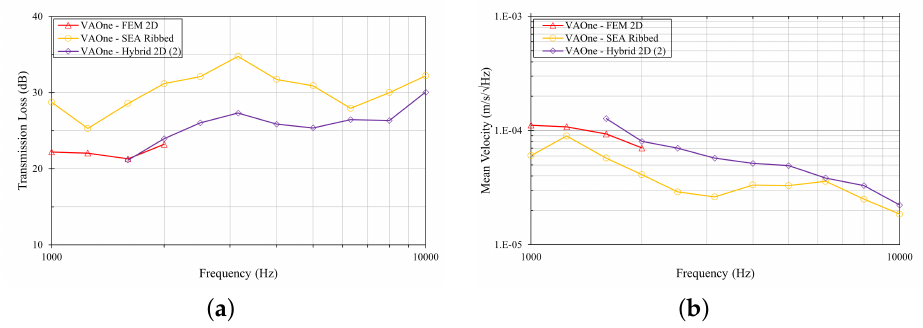
Figure 21. Vibro-acoustic responses of a panel with unconventional stringers: ( a ) sound transmission loss and ( b ) space-average mean vibration velocity.